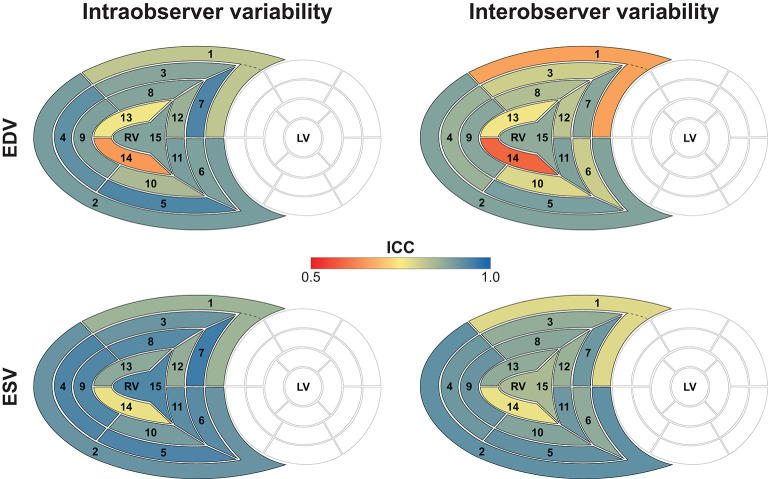
Intra- and interobserver variability of right ventricular end-diastolic and end-systolic segmental volumes. The 15 segments are color-coded based on the value of the intraclass correlation coefficient: reddish colors indicate a lower, whereas blueish colors correspond to a higher value of intraclass correlation coefficient in the given segment. Segment numbers as defined in Figure 3. EDV, end-diastolic volume; ESV, end-systolic volume; ICC, intraclass correlation coefficient; LV, left ventricle; RV, right ventricle.